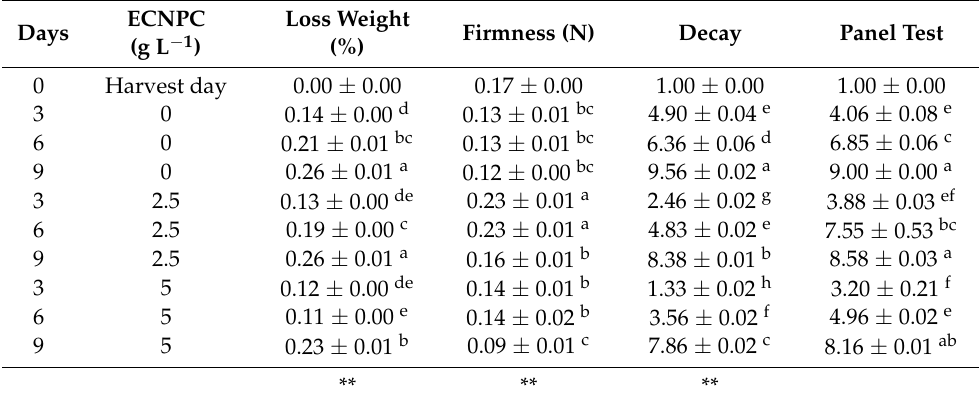
Table 2. Effect of different chitosan nano-emulsion treatments on the quality attributes of raspberry at harvest and in storage time at 4 ± 1 ◦